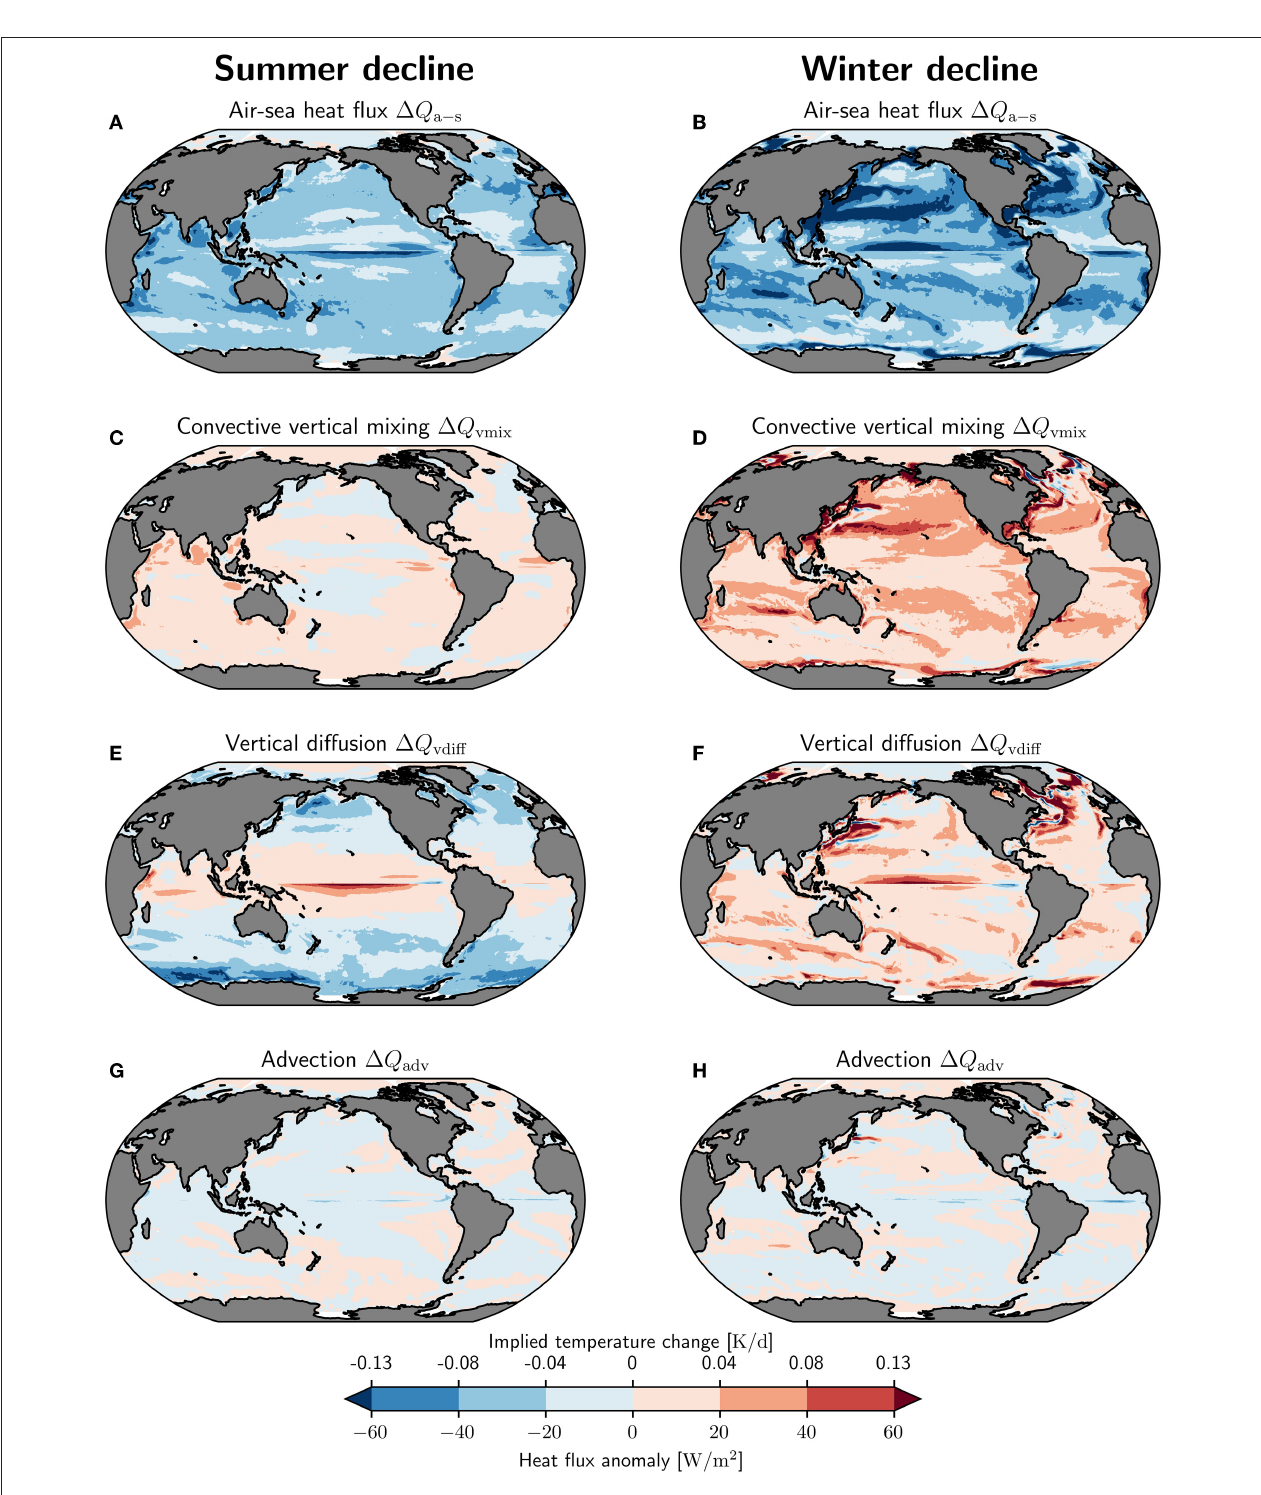
FIGURE 6 | Seasonal decomposition of marine heatwave driver anomaly patterns during the decline phase. Heat flux anomalies for the four most important marine heatwave drivers averaged over marine heatwave decline days during summer (A,C,E,G) and winter (B,D,F,H) . The summer and winter maps show the anomalies averaged over the respective season in both hemispheres simultaneously, i.e., for summer (winter), the maps use JJA (DJF) for the Northern Hemisphere and DJF (JJA) for the Southern Hemisphere. The climatological mean state for these terms during summer and winter is given in Supplementary Figure 3 .